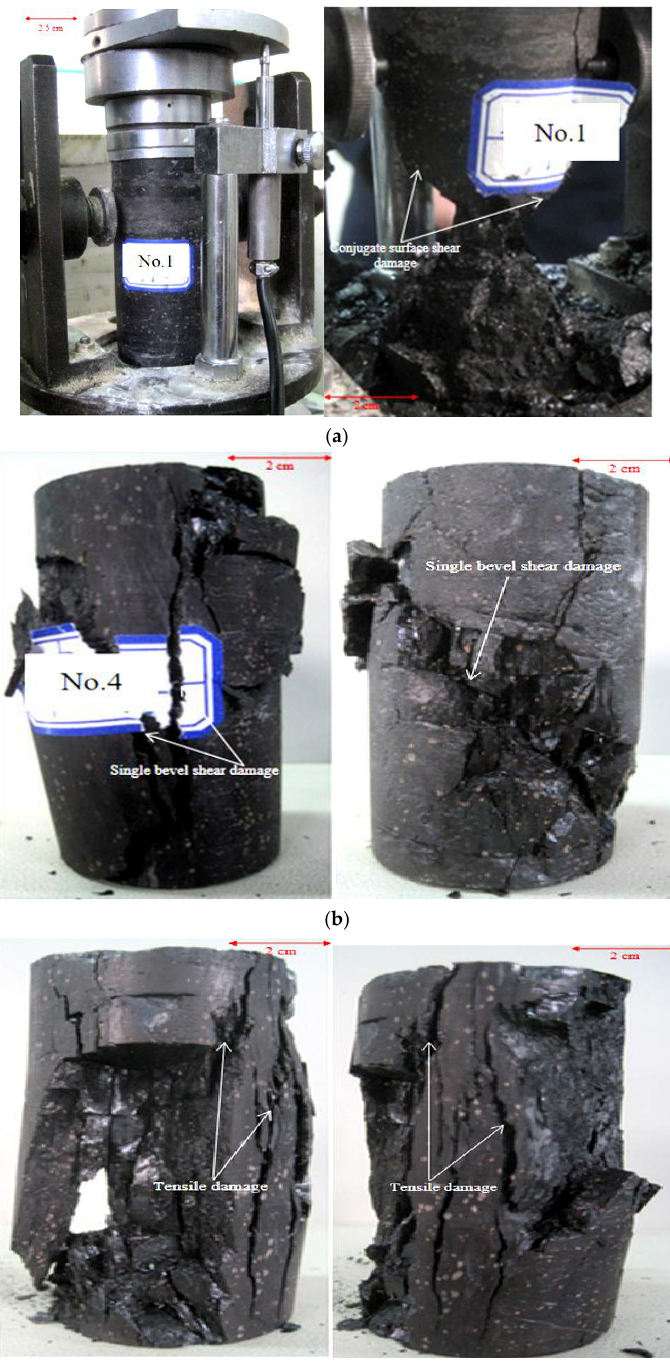
Figure 4. Partial coal specimen compressive strength test failure mode. ( a ) 1-1# test piece. ( b ) 1-4# test piece. ( c ) 1-9 # test piece.